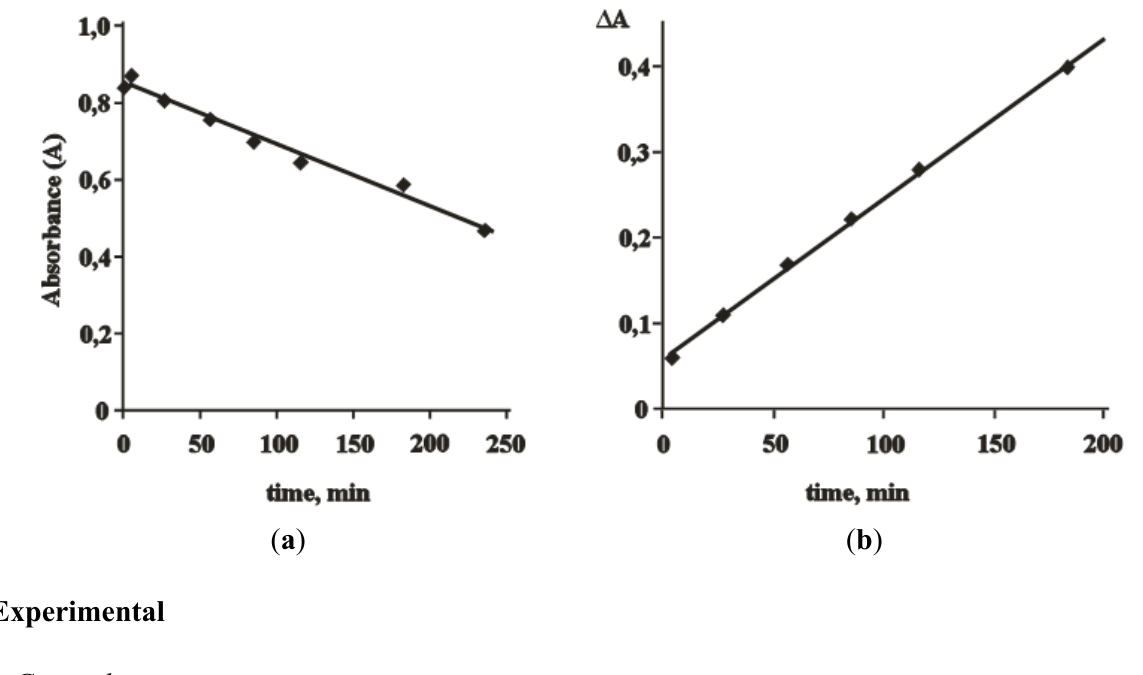
Figure 7. Dynamic range of the absorption at 360 nm ( a ) A = f ( τ ) during synthesis for supernatant liquid of reaction mixture under condition: C ν / ν = 3; m /m = 10. 20-times dilution of sample was carried out by Cr 6+ betulin betulin Al 2 (SO 4 ) 3 CH CN–DMSO in volume ratio as 10:1. ( b ) Δ A = f ( τ ), where Δ A = A 3 – initial absorption; A – the absorption in a time of A in car